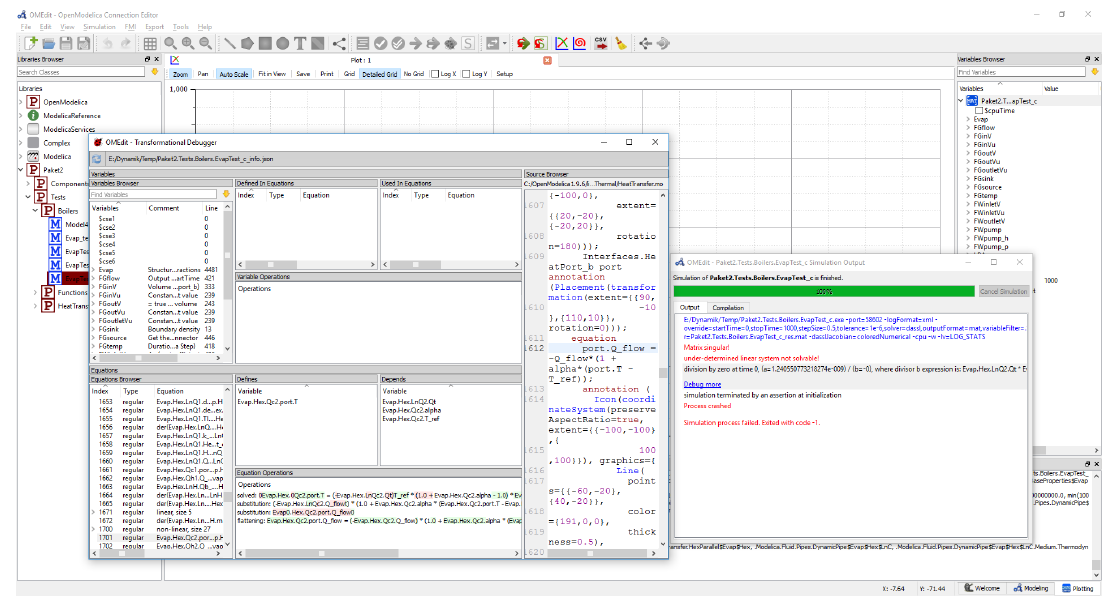
Figure 7: Outputs after no use of heat transfer speci(cid:28)ed but corresponding heat transfer connectors any way